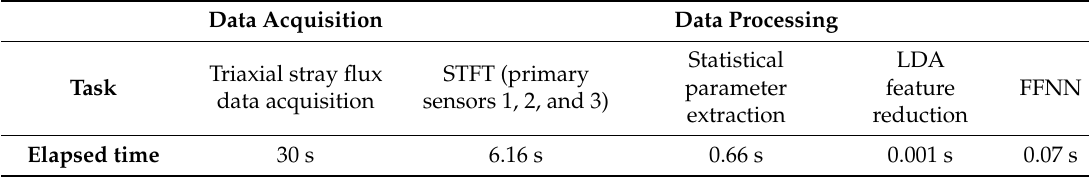
Table 1. Elapsed time for data acquisition and data processing performed by the smart-sensor. STFT, short time Fourier transform; LDA, linear discriminant analysis; FFNN, feed-forward neural network.